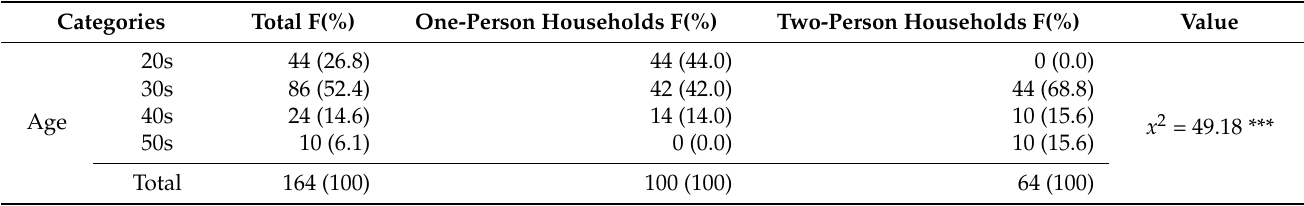
Table 3. Age of the Participants.